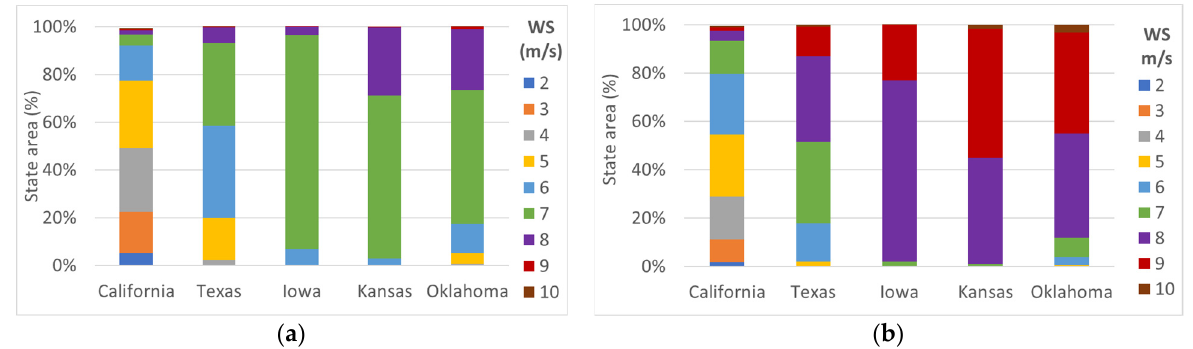
Figure 8. Area classification according to average wind speed ranges for five states with the highest wind energy installed capacity ( a ) at 50 m height and at ( b ) 100 m height.